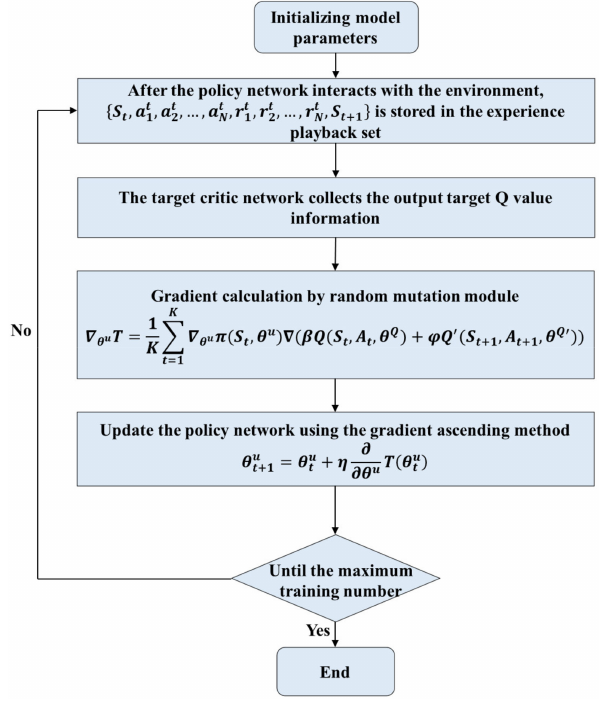
Figure 3. Working flow chart of random mutation module. Table 2. The pseudo-code of the MPT-NCE